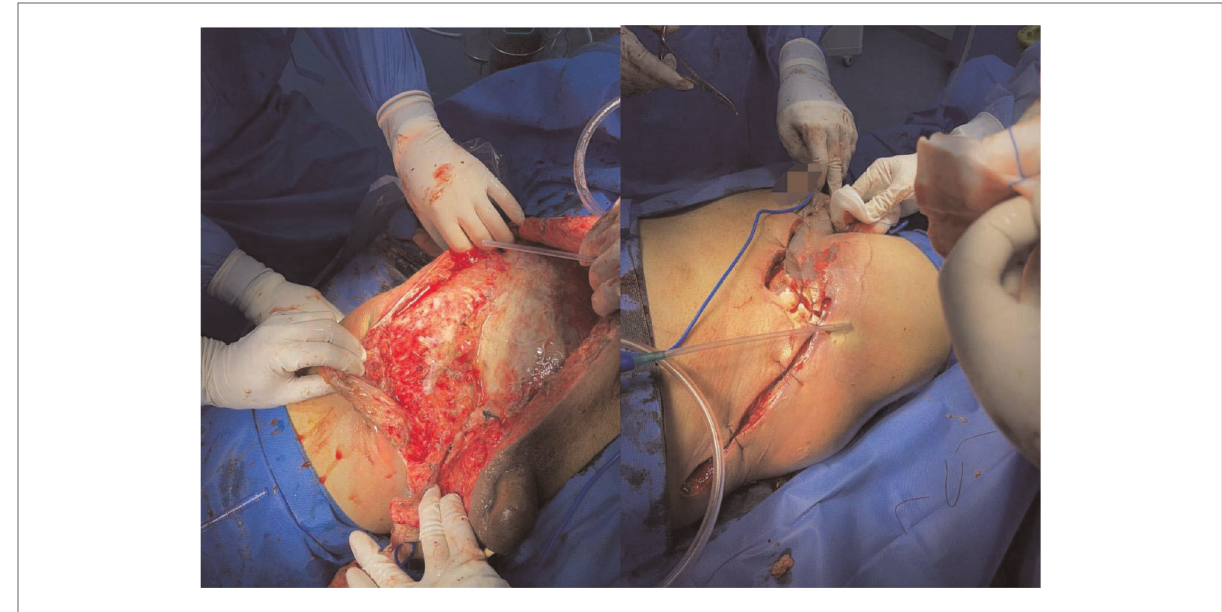
FIGURE 3 In secondary debridement, expand the incision and turn over the skin to both sides.